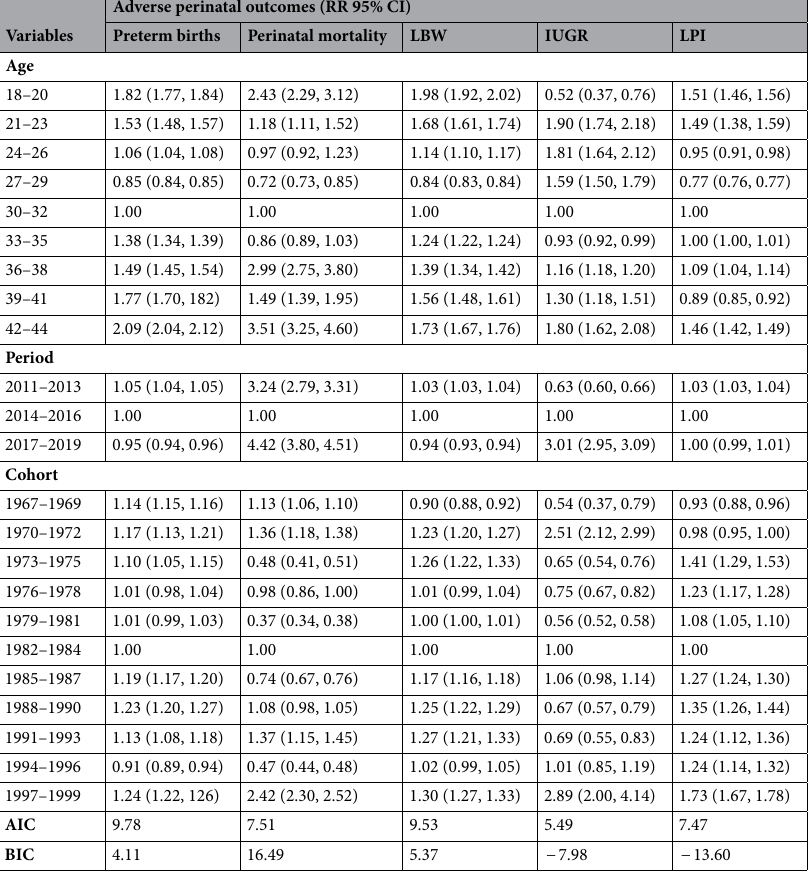
Table 4. Age-Period-Cohort effects on preterm births, perinatal mortality, LBW, IUGR and LPI. LBW Low birth weight, IUGR Intra-uterine growth restriction, LPI Low ponderal index, RR risk ratio, CI confidence interval, AIC Akaike information criterion, BIC Bayesian information